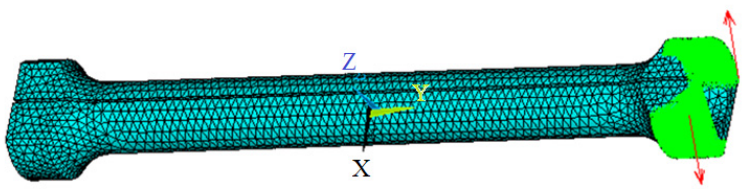
Figure 9. Finite element model of torsional thin-walled bar with an open cross-section.